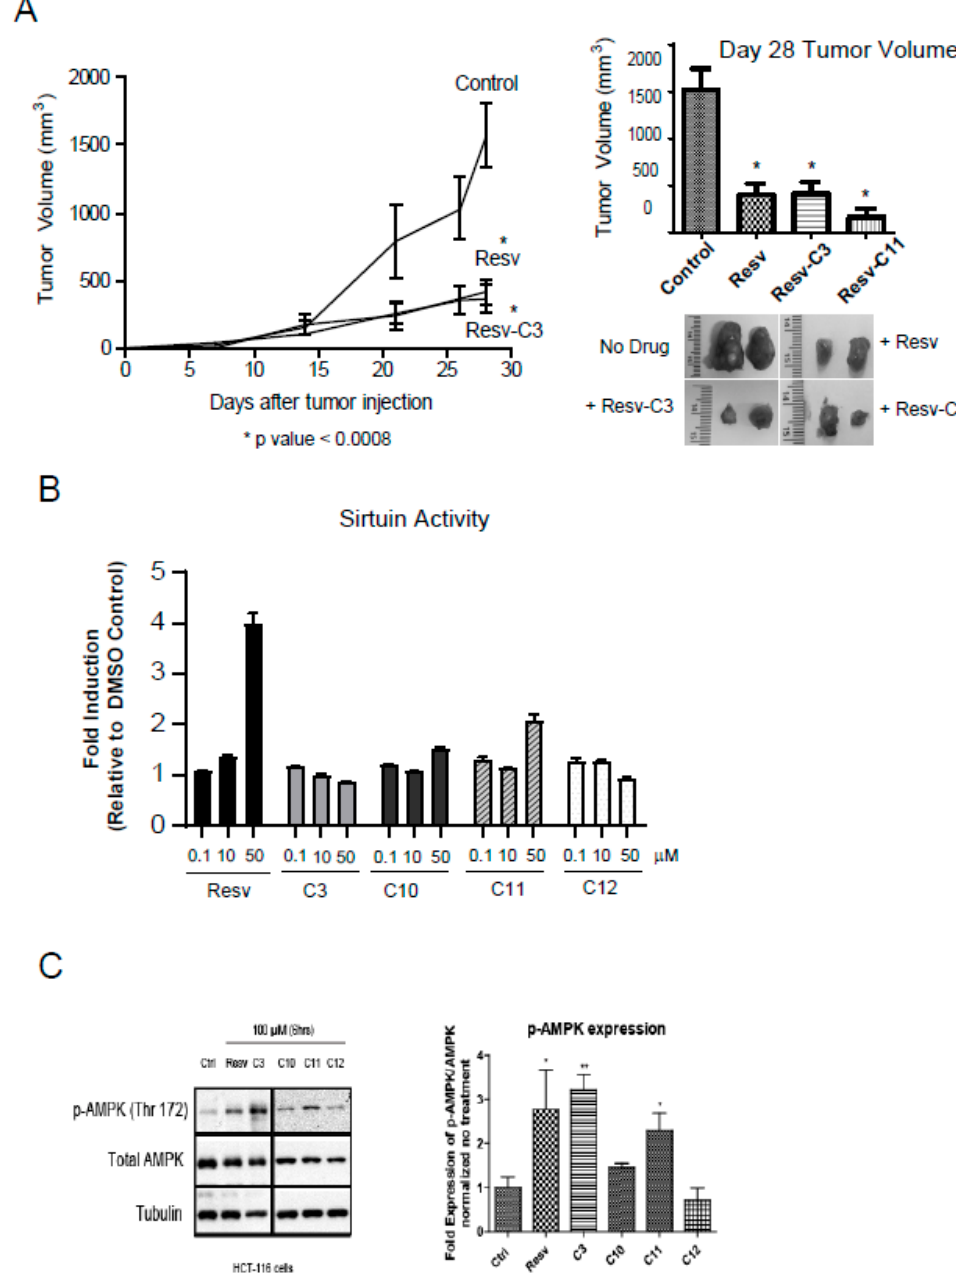
Figure 6. Resveratrol-treated mice reveal reduced tumor burden in a xenograft model. ( A ) HCT116 colon cancer cells were injected subcutaneously into the flanks of athymic mice and tumor formation was monitored over 28 days. Resveratrol fed mice (as in ( A )) at 4 mg resveratrol / g (or 0.017 mmols / g) of food or Resv-C3 / Resv-C11 injected intraperitoneally at 0.3 mmol / kg (or 68.4 mg / kg) body weight every two days we examined for tumor formation. Left panel, the time course of tumor formation (note that Resv-C11 graph overlapped with resveratrol diet and Resv-C3 and was excluded from the plot for clarity). Right panel, day 28 tumor volumes with representative pictures of tumors excised from the animal. For * p values range from 0.0001 to 0.0005 and n = 10–15. ( B ) Analysis of sirtuin assay using various aspirin-resveratrol derivatives. n = 3–4 replicates. ( C ) HCT116 cells with the drugs for 24–48 h and then harvested and Western blot for pT172 AMPK and total AMPK as shown in the left panel and quantitated in the right panel. Analysis was performed using an Image J open source